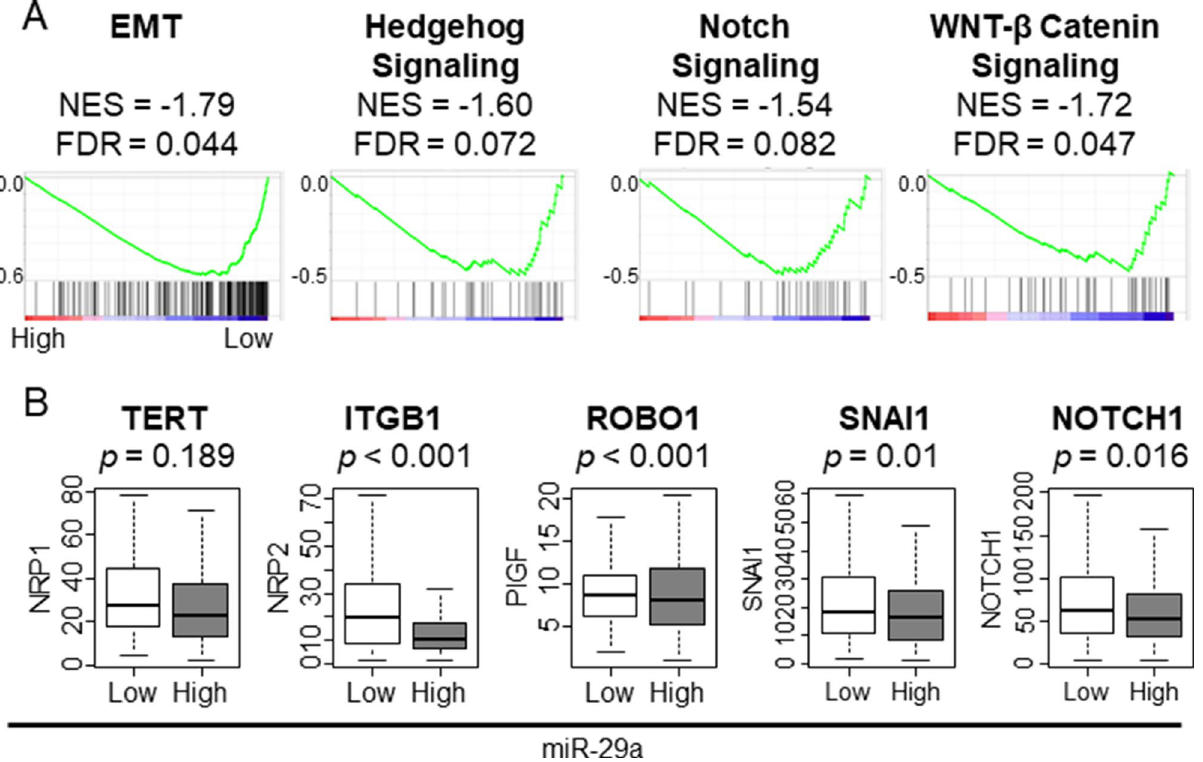
normalized enrichment score, FDR false discovery rate. The statistical significance was defined by p < 0.05 or FDR < 0.25. Tukey-type boxplots demonstrate median and inter-quartile level